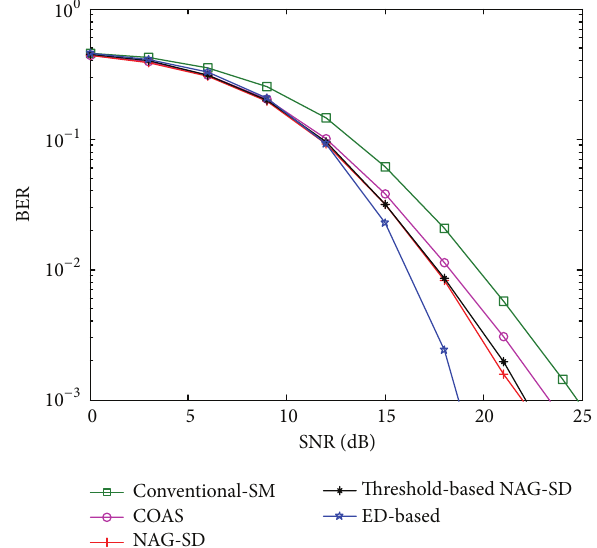
Figure 3: BER performance of different TAS schemes in SM-MIMO with 𝑁 𝑡 = 100 , 𝑁 𝑟 = 4 , and 𝑁 𝑠 = 64